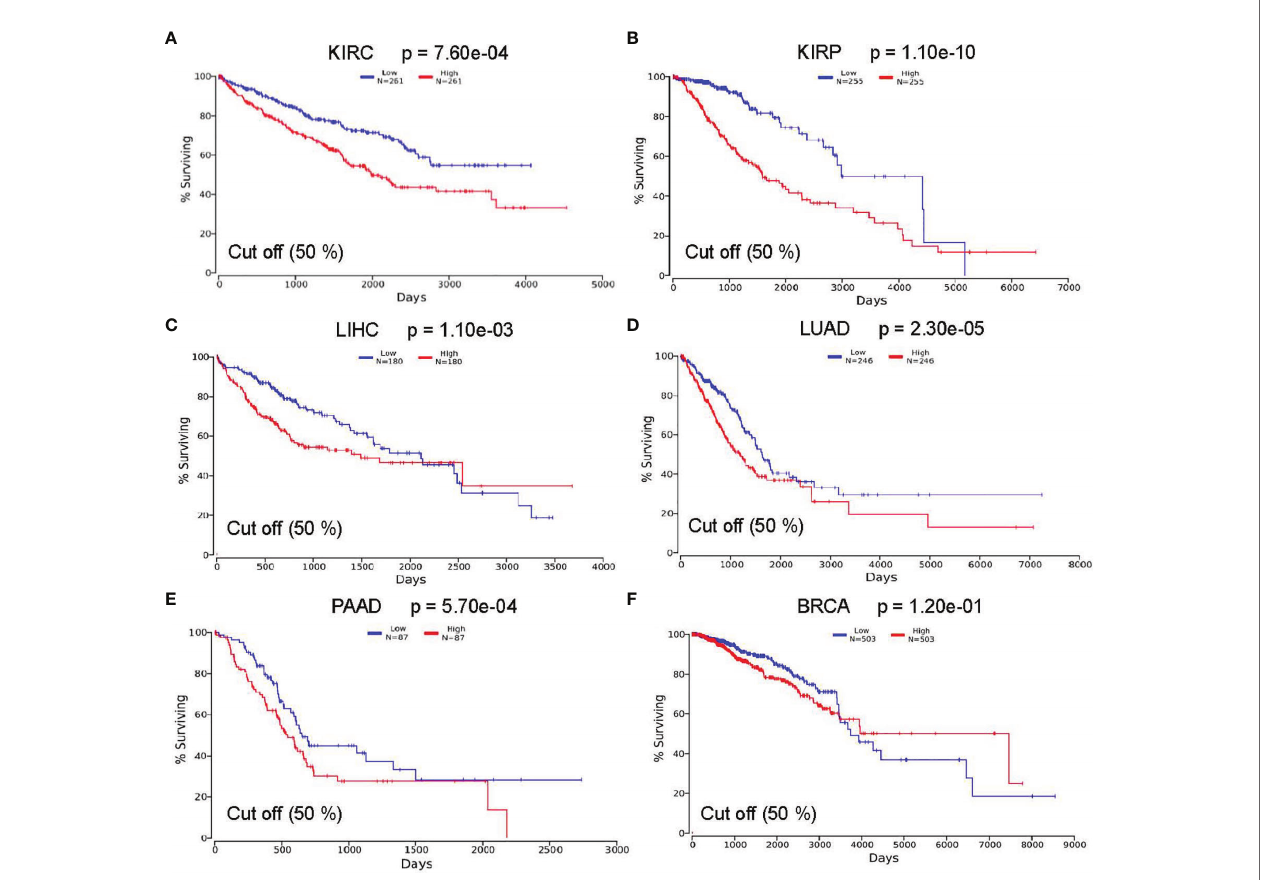
FIGURE 4 | Correlation between ASPM expression and survival outcomes using the OncoLnc online tool. The relationship between the expression level of ASPM and the survival rate of (A) KIRC (Low: n = 261; High: n = 261); (B) KIRP (Low: n = 255; High: n = 255); (C) LIHC (Low: n = 180; High: n = 180); (D) LUAD (Low: n = 246; High: n = 246); (E) PAAD(Low: n = 87; High: n = 87); and (F) BRCA (Low: n = 503; High: n = 503)